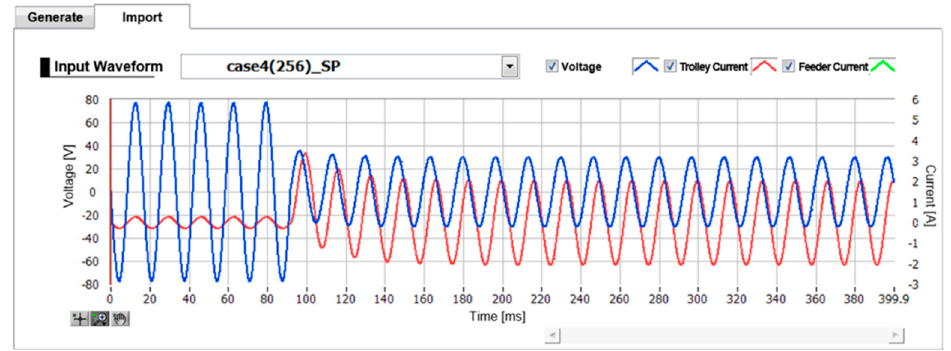
Figure 7. External (PSCAD/EMTDC COMTRADE) input waveform.